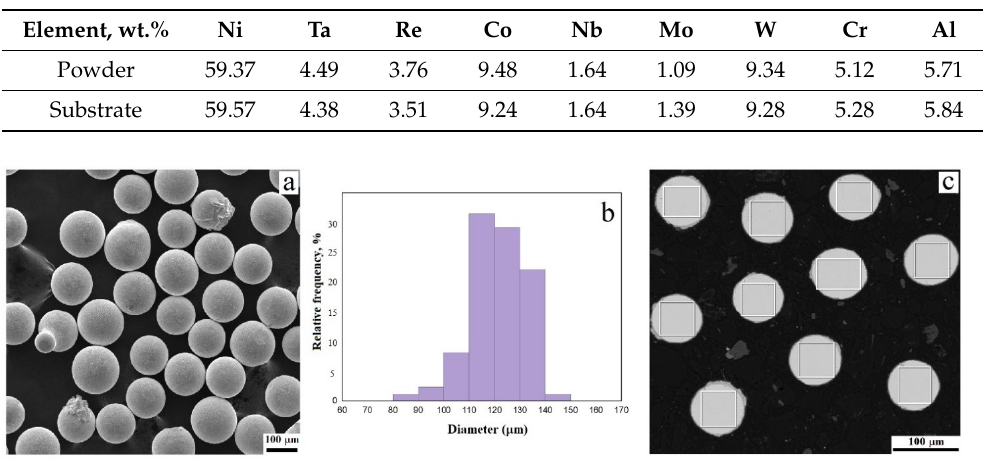
Table 2. Chemical composition of powder and substrate material.